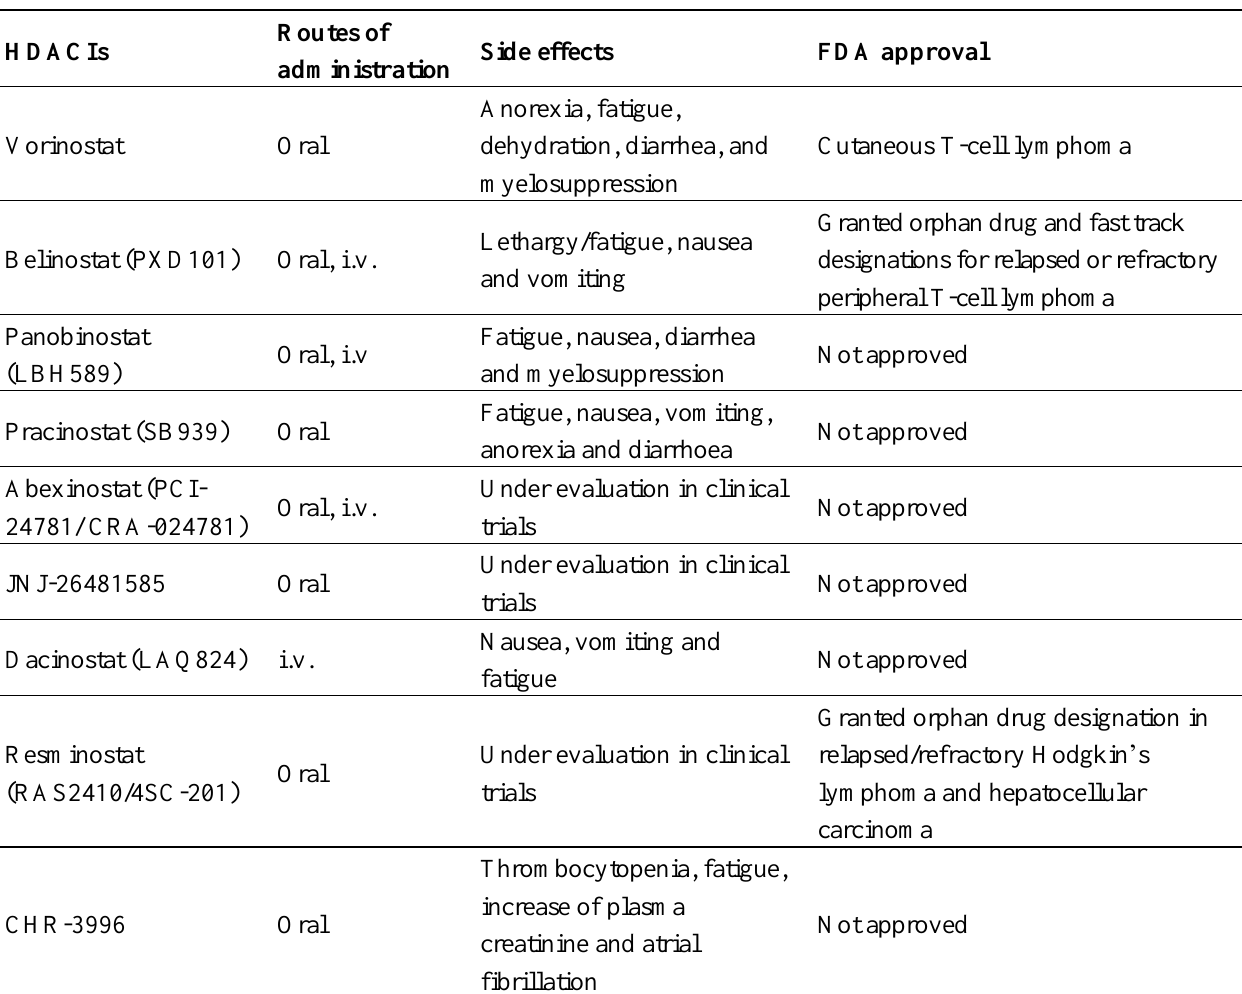
Table 2. Hb-HDACIs in the